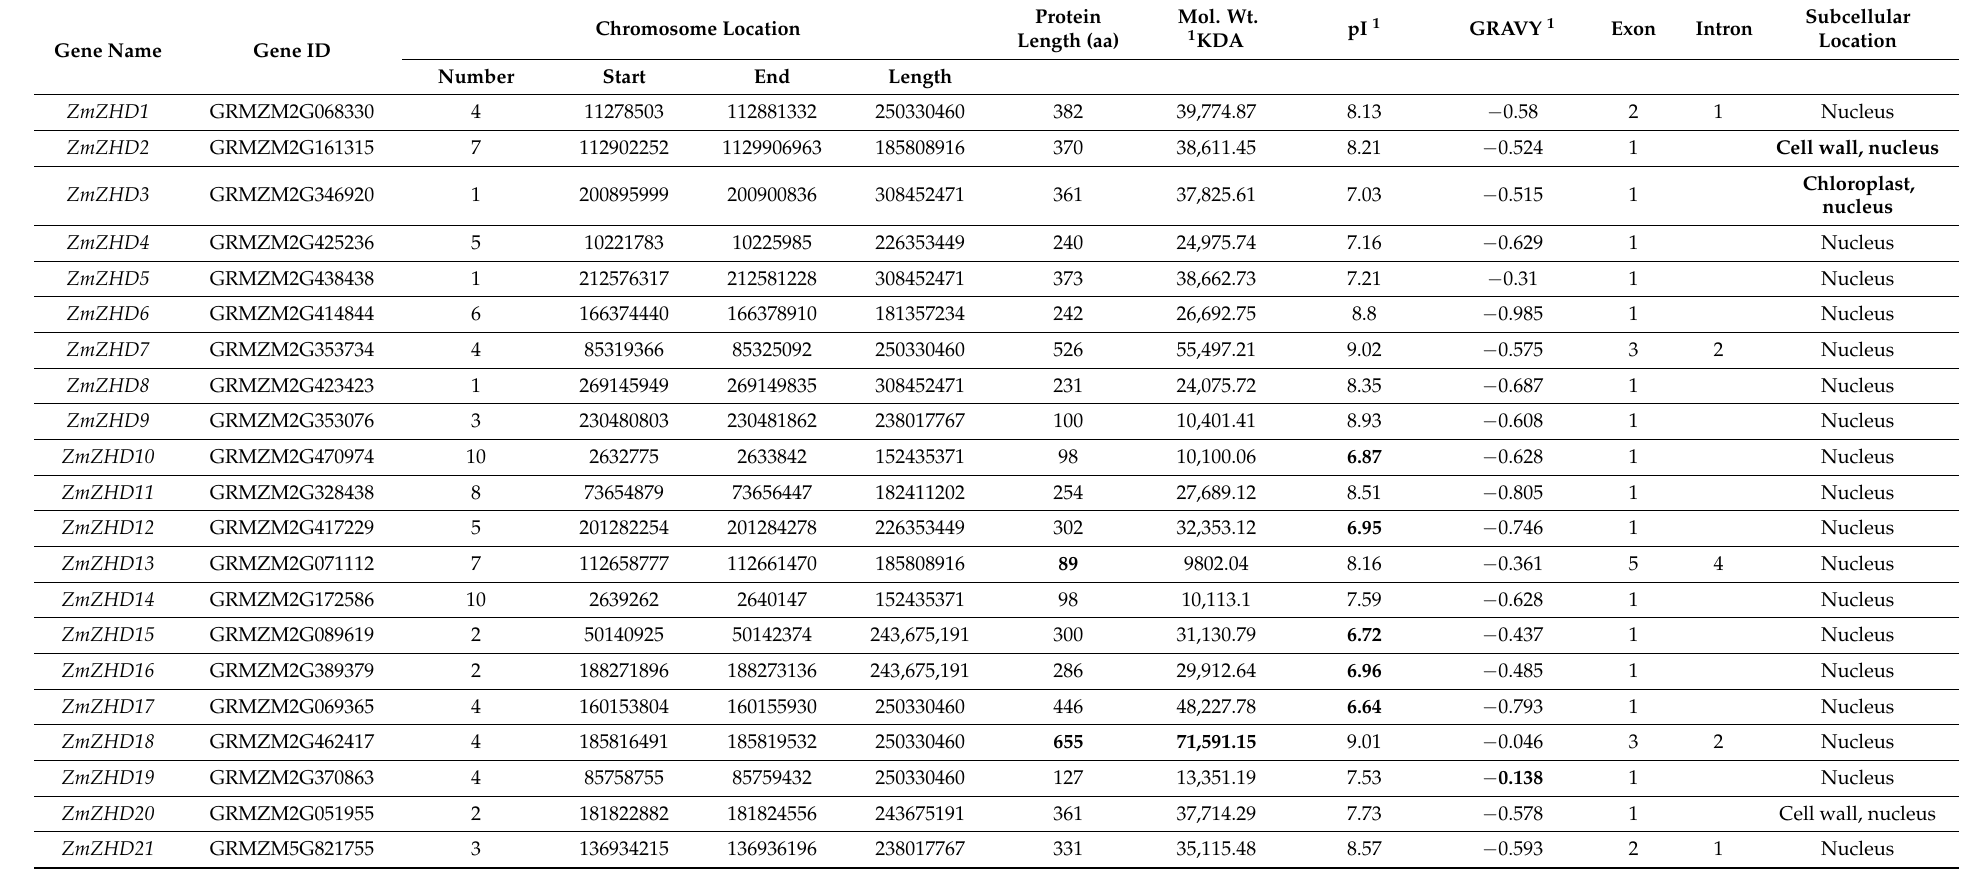
Table 1. Detailed information about the ZmZHD genes and corresponding proteins in Z. mays